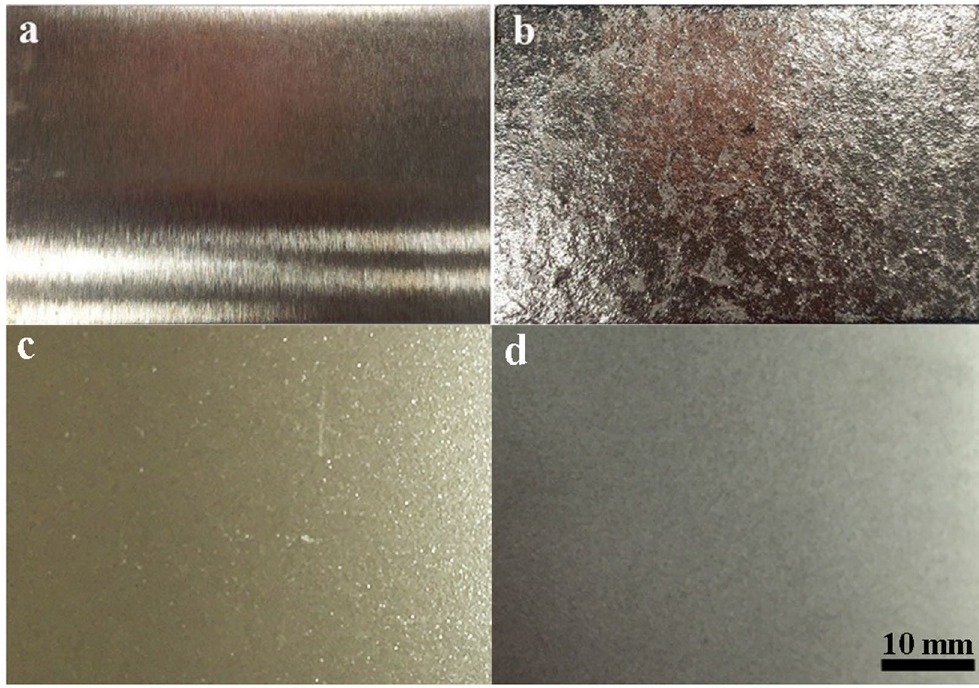
Figure 2. Surface profiles of WL10 that are ( a ) untreated, ( b ) WC ball treated, ( c ) ZrO 2 ball treated, and ( d ) steel ball treated.